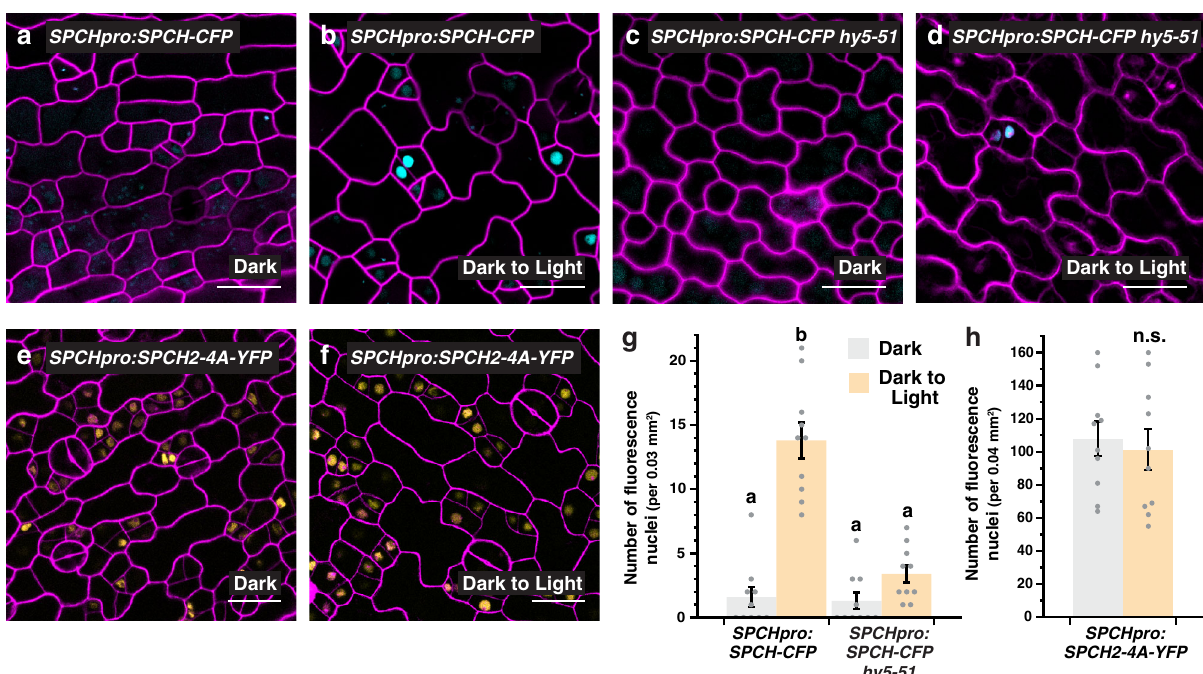
Fig. 2 HY5 regulates the light-induced accumulation of SPEECHLESS. a – d , g Analysis of a translational reporter of SPEECHLESS ( SPCH ) in WT ( a , b ) and hy5-51 ( c , d ) under light and dark conditions. Confocal images of 3-day-old abaxial cotyledons of SPCHpro:SPCH-CFP , which were grown in darkness and were either kept in the dark ( a , c ) or transferred to the light for 6 h ( b , d ) before imaging. Images were taken with the same excitation and acquisition settings. The numbers of CFP-expressing cells (cyan) in an area are quanti fi ed ( g ). e , f , h Analysis of a MAPK-insensitive translational reporter of SPCH . Confocal images of 3-day-old abaxial cotyledons of SPCHpro:SPCH2-4A-YFP grown in darkness ( e ) or exposed to light ( f ) (see above). The numbers of YFP- expressing cells (yellow) are quanti fi ed ( h ; color scheme of bar chart as in g ). Values are mean + / − SEM, n = 10 independent cotyledons. Two-way ANOVA with Tukey ’ s multiple comparisons test, P < 0.01 ( g ) or two-tailed Student ’ s t test, n.s., not signi fi cant ( h ). Cell outlines were visualized with propidium iodide (magenta). Scale bar, 20 μ